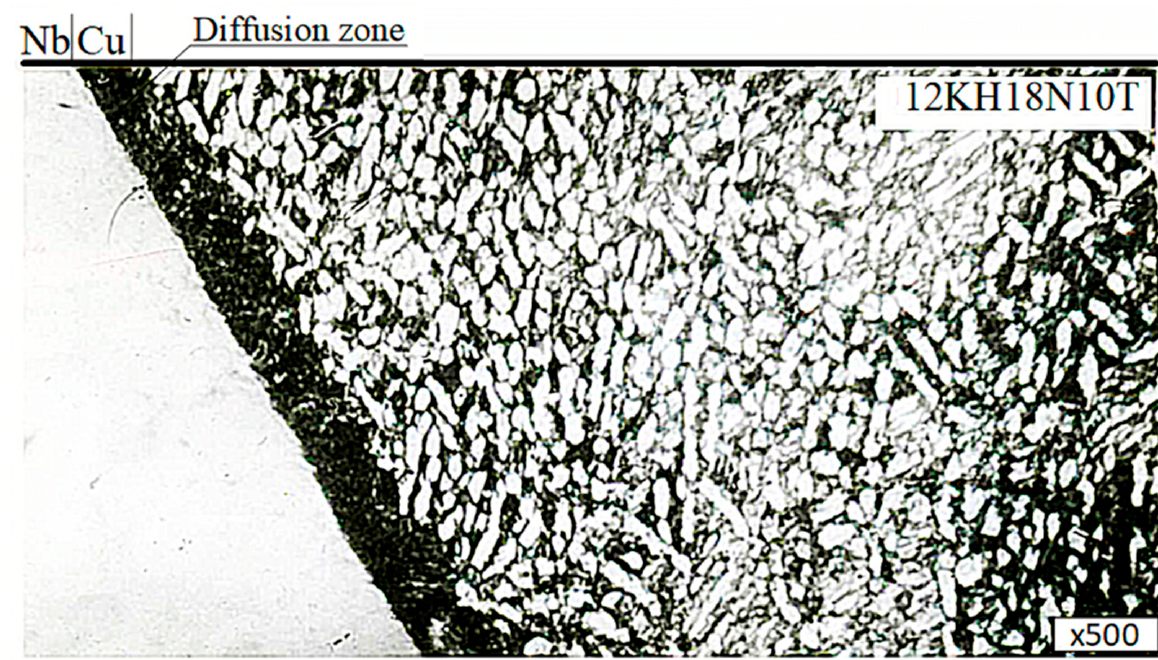
Figure 13. Connection area of 12KH18N10T stainless steel and copper.